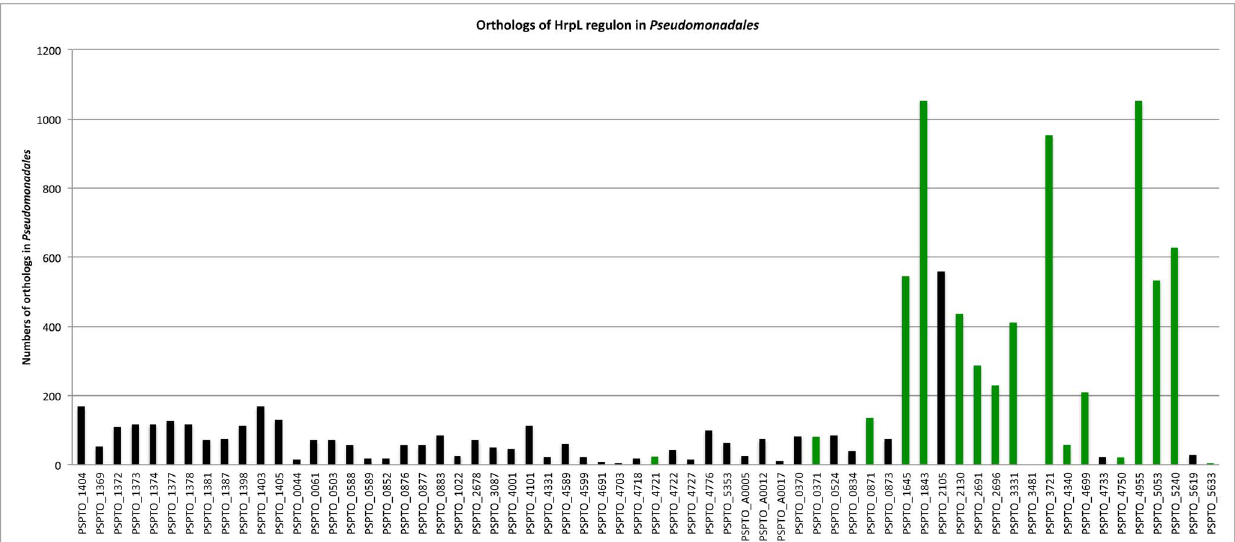
Figure 7. Ortholog inventory of HrpL regulon in Pseudomonadales . Green represents newly found members; black represents previously annotated regulon members. The values shown represent counts of orthologs of HrpL regulon members across 1060 species.